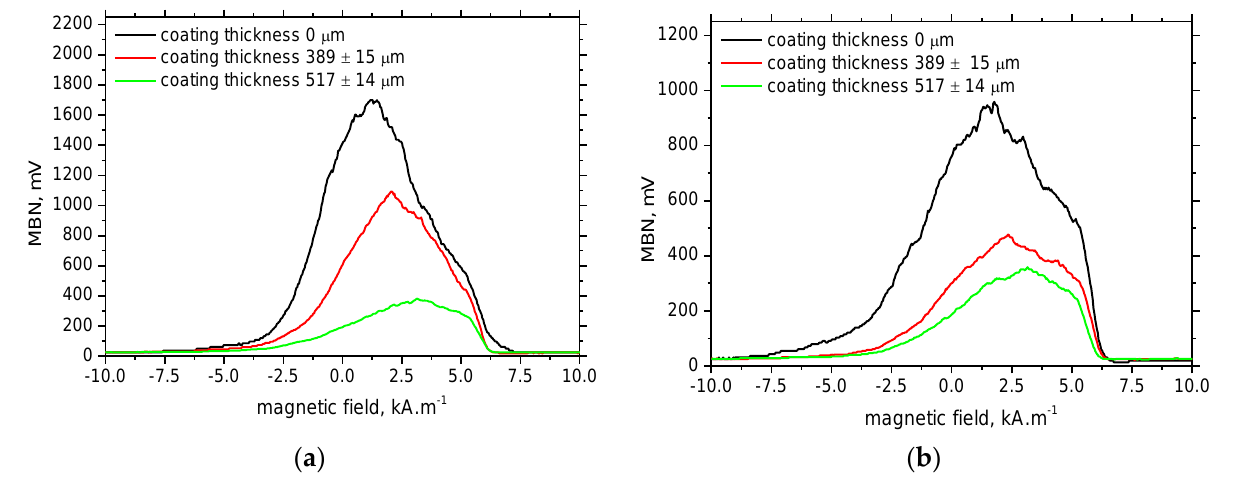
Figure 6. MBN envelopes. ( a ) Rolling direction (RD) and ( b ) TD.